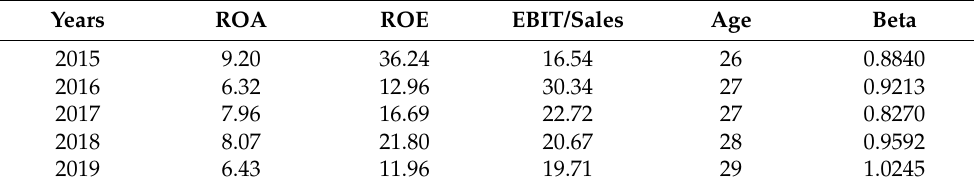
Table 6. Profitability, age, and Beta of investigated companies in